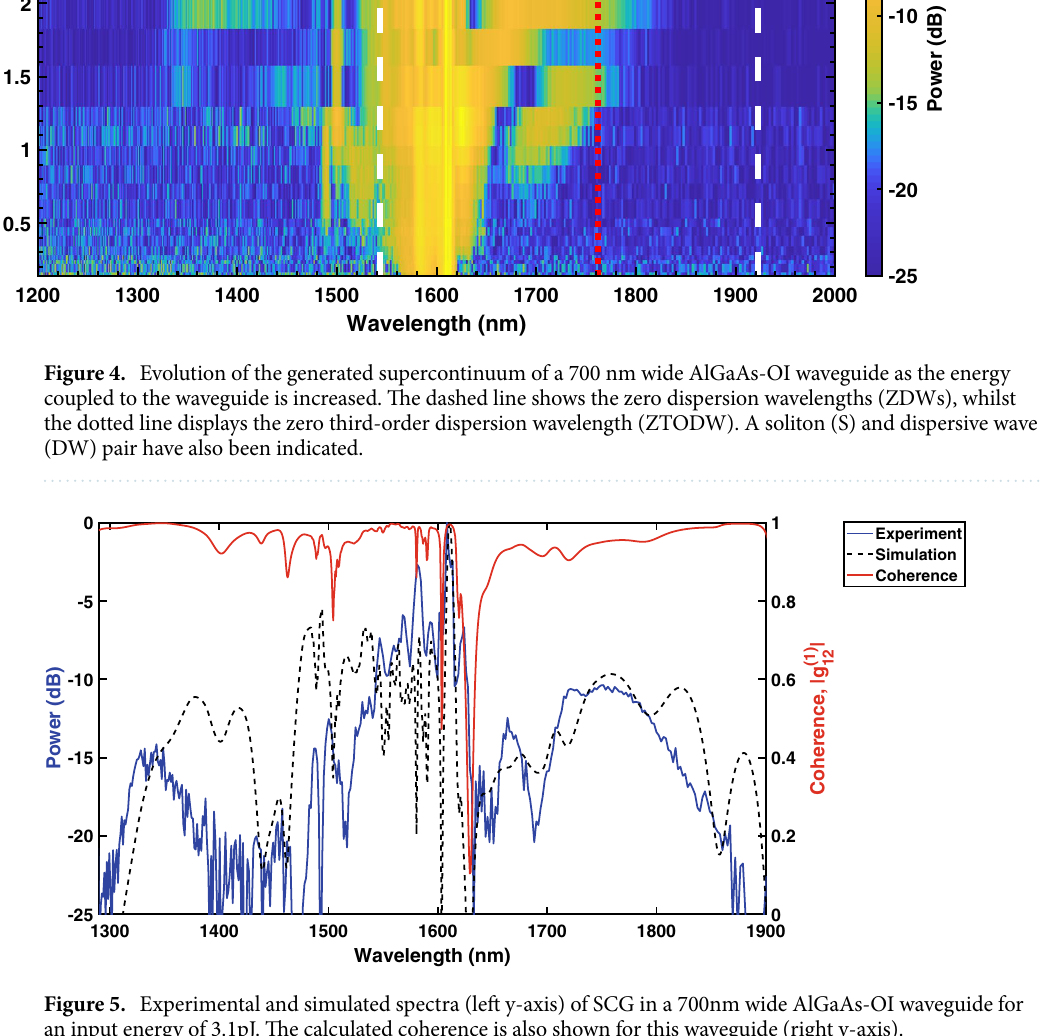
Figure 5. Experimental and simulated spectra (left y-axis) of SCG in a 700nm wide AlGaAs-OI waveguide for an input energy of 3.1pJ. The calculated coherence is also shown for this waveguide (right